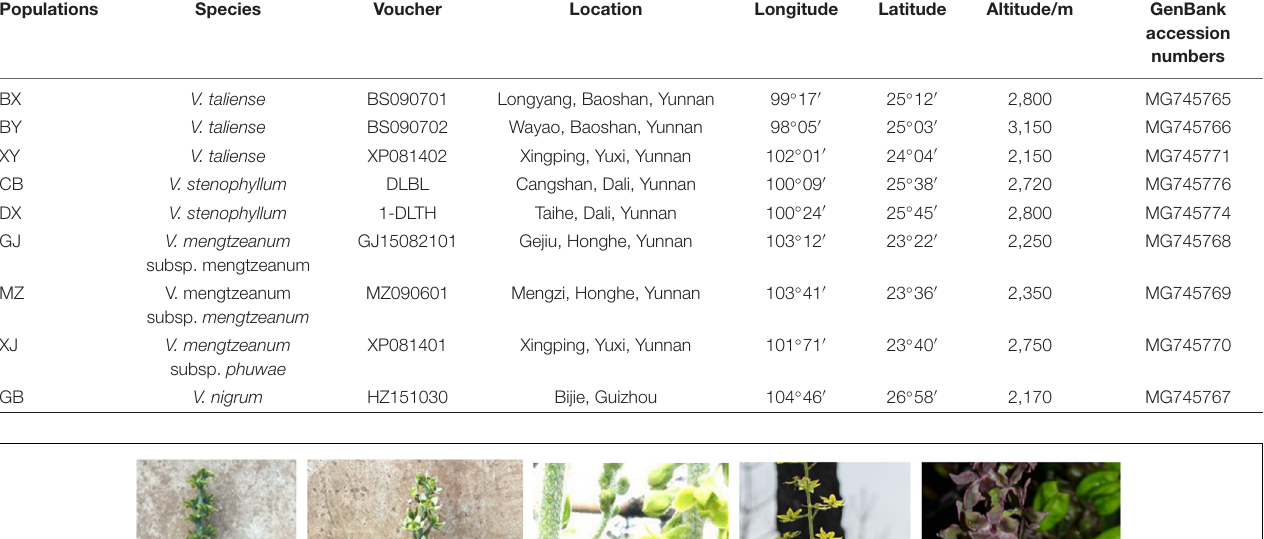
TABLE 1 | Information of samples.